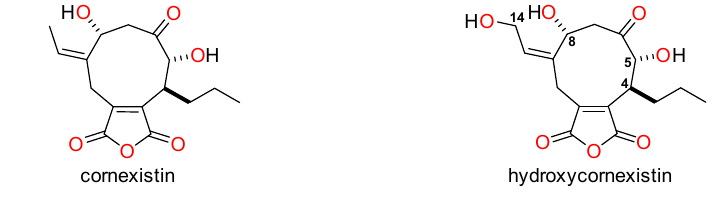
Figure 1. The cornexistin natural products.